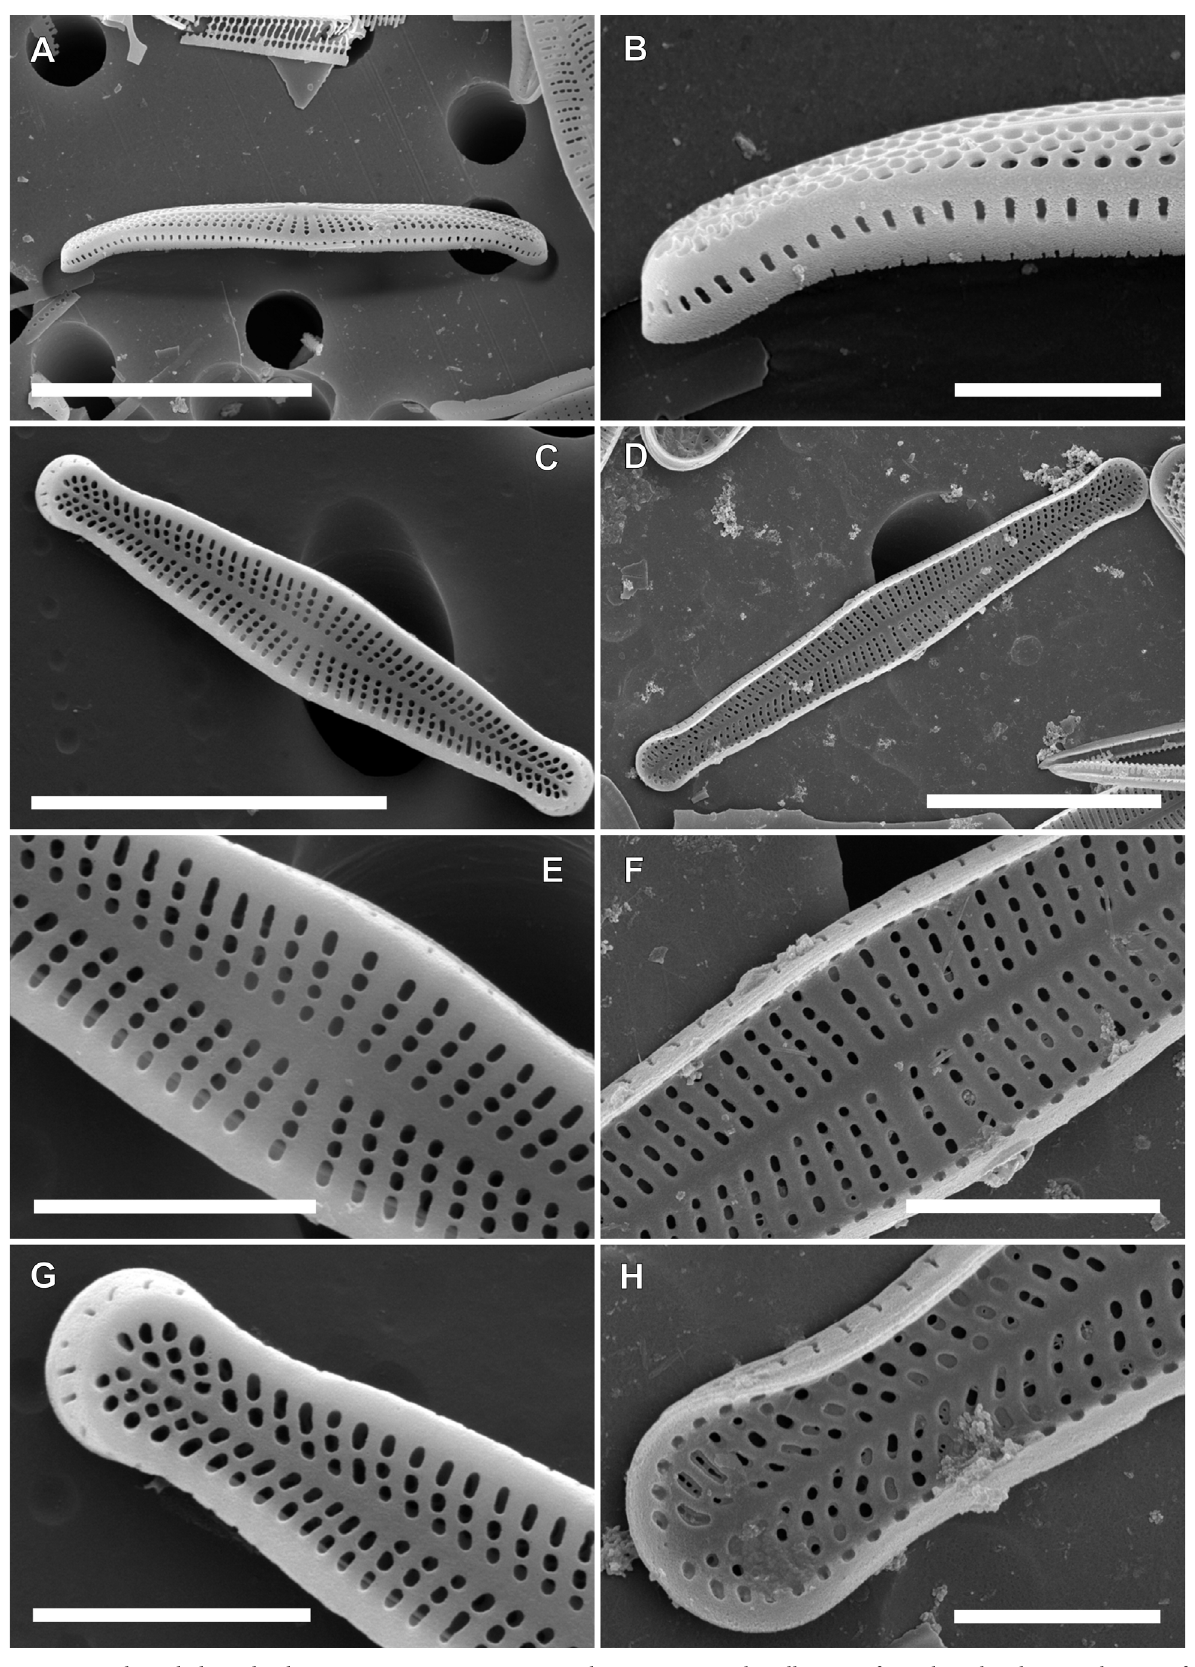
Figure 7. Achnanthidium dumlupinarii sp. nov., SEM micrographs. A , B . External girdle view of a raphe valve showing the row of areolae in the mantle. C . General external valve view of a rapheless valve. D . General internal valve view of a rapheless valve. E , F . Details of central area. G , H . Details of apices. Scale bars 10 µm (A, C, D), 2 µm (B,